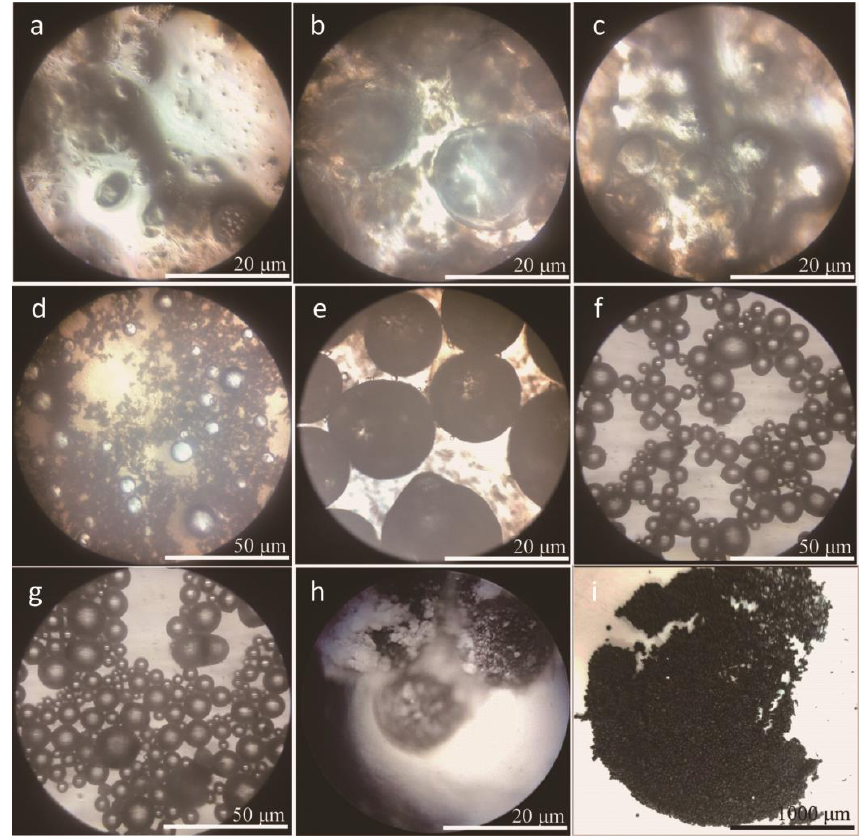
Figure 2. Optical microscope morphologies of self-healing microcapsules with 2% content of graphene in shells fabricated by a two-step polymerization, ( a ) oily rejuvenator emulsified by hydrolyzed SMA, ( b ) HMMM prepolymer added in emulsion, ( c , d ) the first-step polymerization, ( e ) HMMM prepolymer and graphene mixture added again, ( f , g ) the second-step polymerization, ( h ) the filtered microcapsules with impurity on shells, and ( i ) the washed and dried microcapsules.